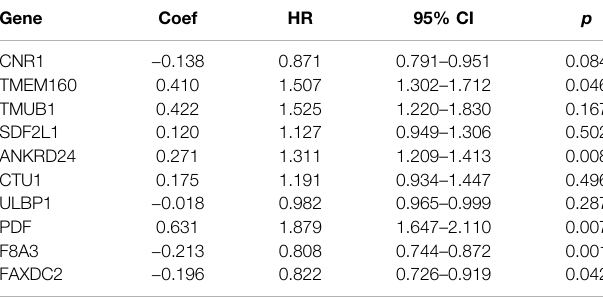
TABLE 1 | Multivariate Cox regression analysis of ten